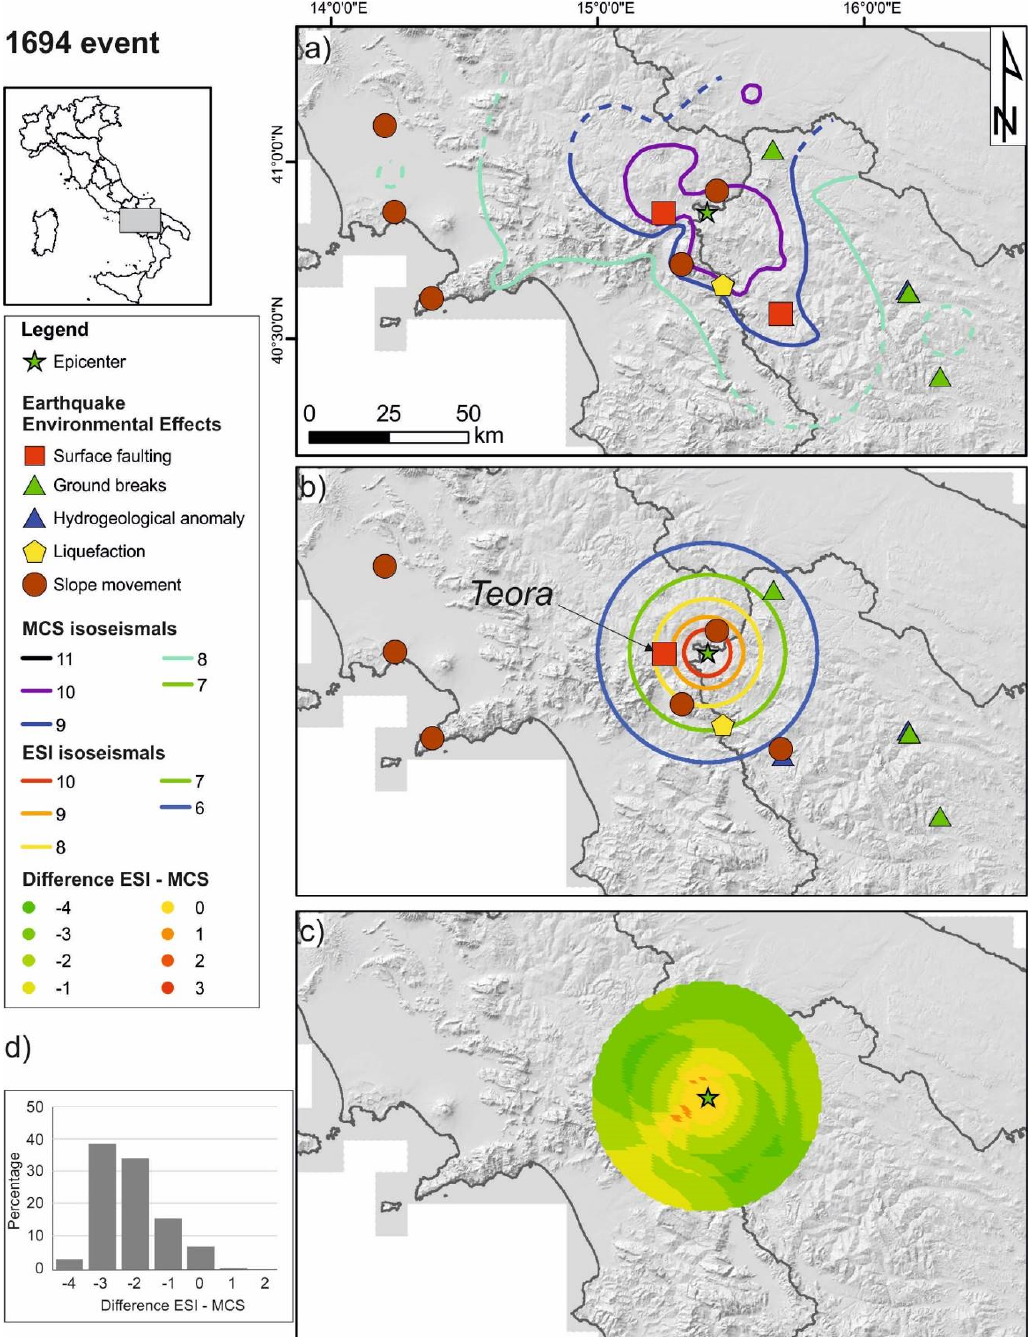
Figure 5. ( a ) map of EEEs and MCS isoseismals, dashed when inferred, of the 1694 earthquake; ( b ) map of EEEs and ESI isoseismals derived from the intensity prediction equation (IPE); ( c ) map showing the difference between ESI and MCS intensities; ( d ) histogram of the ESI-MCS difference. Inset shows, in the grey rectangle, the study area in a larger map around Italy.